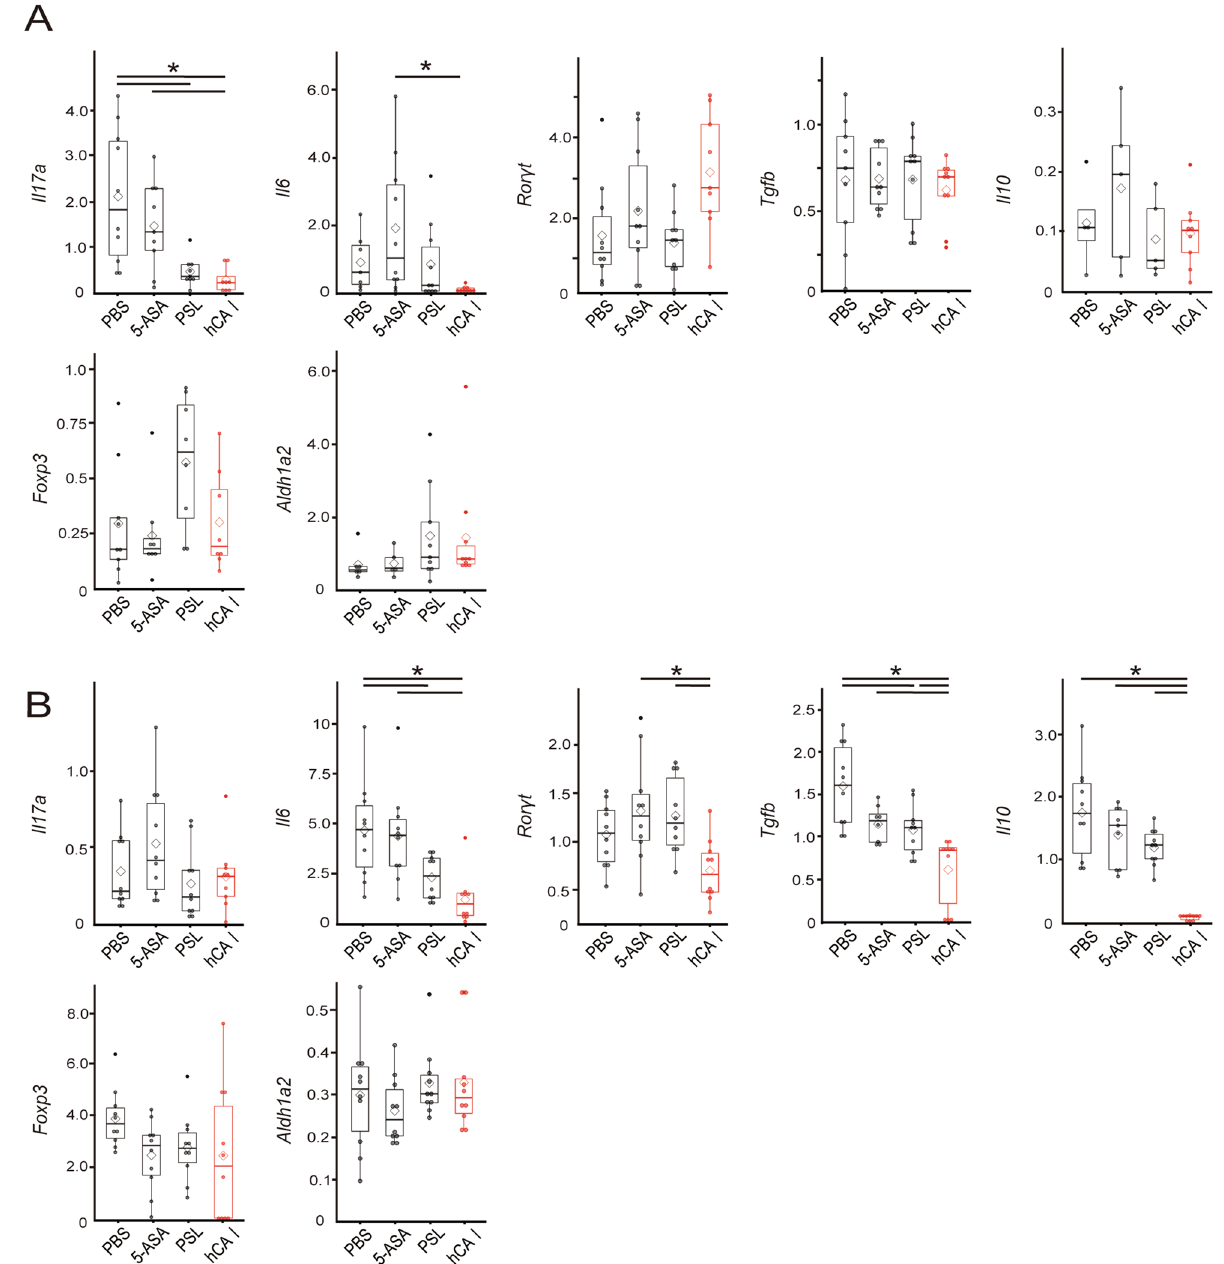
Figure 7. Treatment with orally administered hCA I suppressed inflammatory responses in the colon and MLNs of colitic mice. ( A ) Four weeks after CD4 + CD25 − T cells were transferred, transcription factor or cytokine mRNA expression levels in the colon were quantified using real-time RT-PCR; white diamond indicates the mean, horizontal lines indicate the median, line indicate ± SD of 6–11 mice/group. ( B ) Transcription factor or cytokine mRNA expression levels in MLN cells were measured using real-time RT-PCR; mean ± SD of 8–10 mice/group. * P <